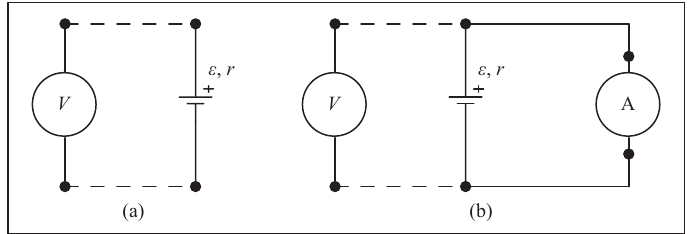
Fig. 2. The potential difference and the electromotive